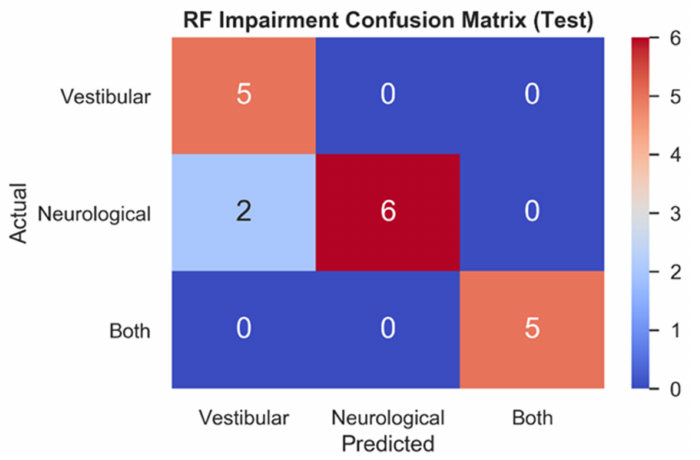
Figure 4. Testing set confusion matrix of RF model. Model predictions for each impairment ( x -axis) are contrasted with actual impairment outcomes ( y -axis) to categorize the correct and incorrect predictions made.